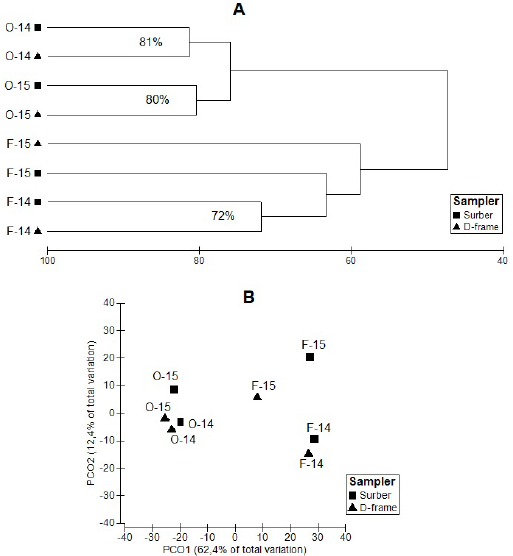
Figure 4. Results of the Hierarchical Clustering analysis (A, with the percentage of similarity grouping the samplers) and Principal Coordinates analysis (B) constructed with data of total OTU’s sampled with Surber and D-frame net in reaches of Farias stream with (F-forest) and without (O-open) riparian vegetation, in 2014 and